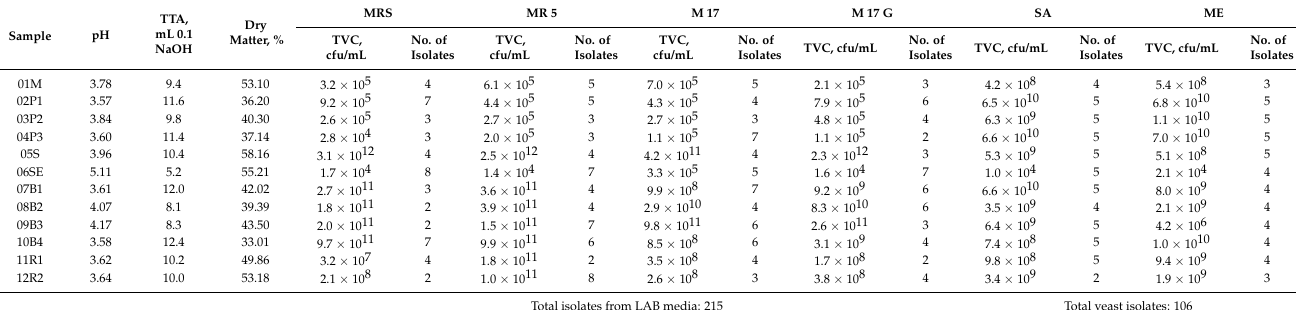
Table 2. Physico-chemical and microbiological characterization of Bulgarian